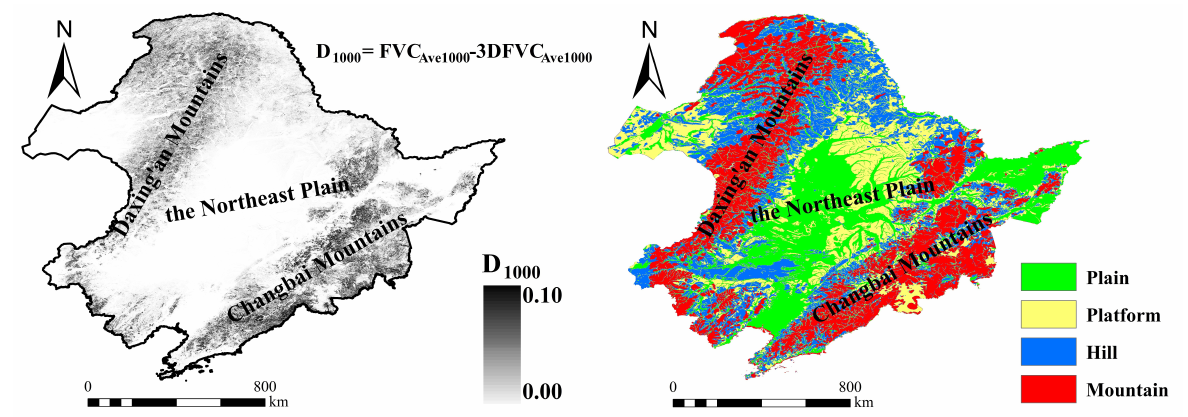
Figure 6. The spatial distribution of terrain and D 1000 .